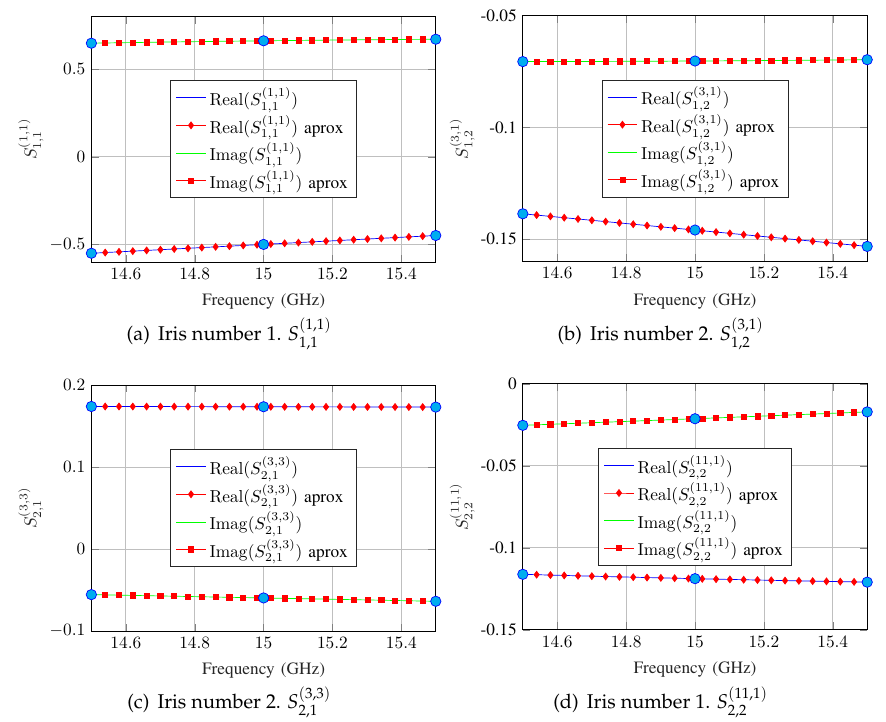
Figure 3. Comparison between accurate and approximate scattering parameters of different blocks of the coupled cavities filter ( R = 9), and different combinations of input and output ports and modes. Big dots show the points used for spline approximation. In this case, using three points was enough for high accuracy